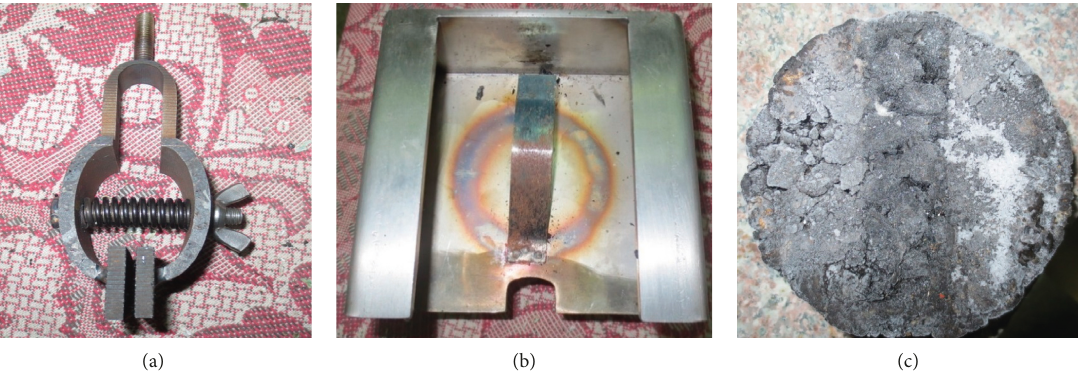
Figure 8: The pictures of various parts. (a) Clamp mold. (b) Base mold. (c) Specimen after